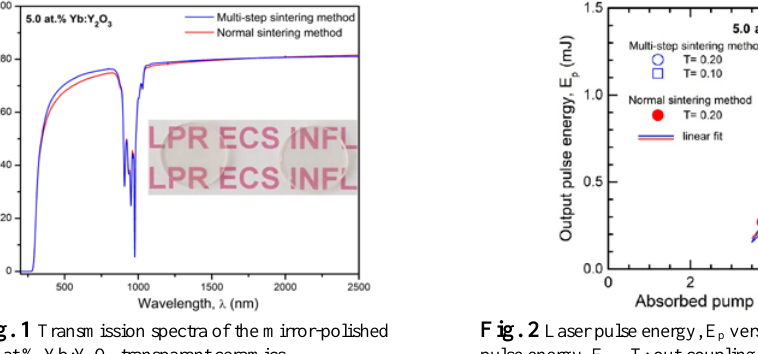
p versus absorbed energy of the pump